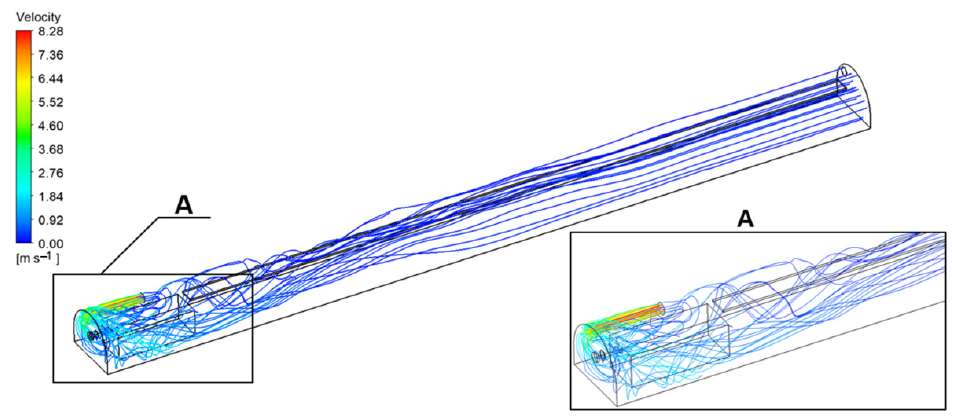
Figure 4. Trajectories of air flowing through the driven dog heading (without dust).